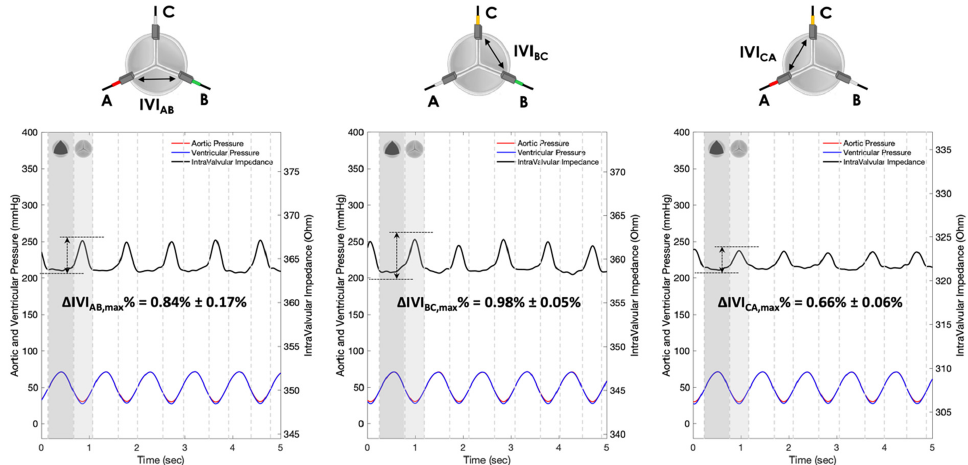
Figure 13. IVI measurements recorded for the three pairs of electrodes of Prototype 1 under altered leaflet dynamics: AB ( left ), BC ( center ) and CA ( right ).